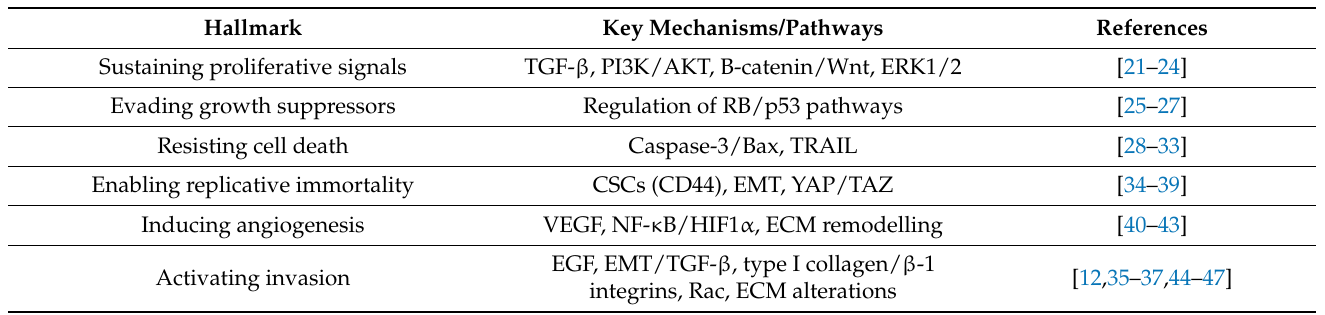
Table 1. TG2 and the hallmarks of cancer. The various mechanisms and signalling pathways shown to be linked to TG2 activity in the hallmarks of cancer. Hallmark Key